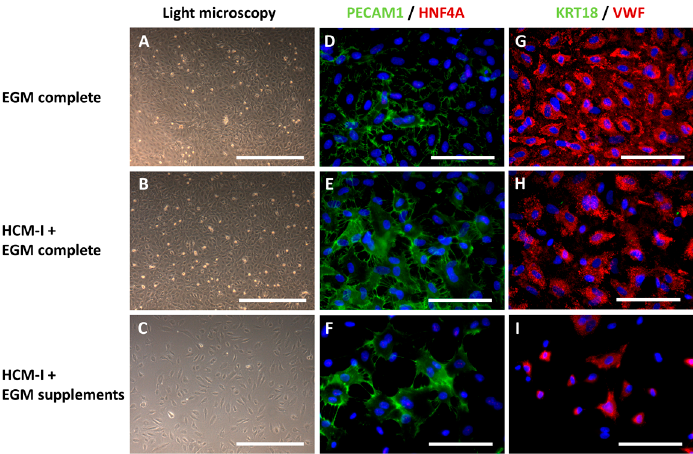
Figure 3. Light microscopy and immunocytochemical staining of mono-cultures of human umbilical vein endothelial cells (HUVEC) after cultivation over 14 days in endothelial cell growth medium, consisting of basal medium and supplements (EGM complete), hepatocyte culture medium and EGM complete mixed at a ratio of 1:1 (HCM-I + EGM complete) or HCM enriched with endothelial cell growth supplements (HCM-I + EGM supplements). The pictures show light microscopic photographs ( A – C ), staining of the endothelial cell marker platelet endothelial cell adhesion molecule 1 (PECAM1) and the hepatocyte marker hepatocyte nuclear factor 4 α (HNF4A) ( D – F ), staining of the hepatocyte marker cytokeratin 18 (KRT18) and the endothelial cell marker von Willebrand factor (VWF) ( G – I ). Nuclei were counter-stained with Dapi (blue). Scale bars correspond to 500 µm for light microscopy and to 100 µm for immunofluorescence.